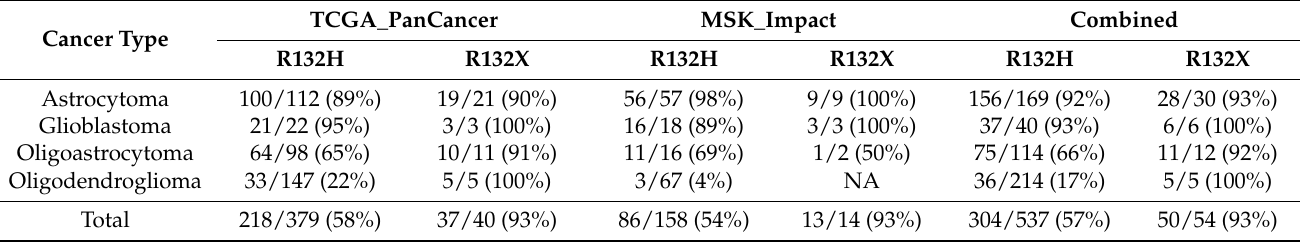
Figure 4. Higher frequencies of co-occurrence of IDH1 hotspot mutation and TP53 alteration in glioma. Glioma and non-glioma were compared for their co-occurrence frequencies of TP53 alteration and IDH1 -R132 mutation ( A ), and TP53 alteration and IDH1 R132H or IDH1 R132X ( B ). * p < 0.05; ** p < 0.01. Table 5. Co-occurrence frequencies of specific IDH1 hotspot mutation and TP53 alteration in different histological subtypes of